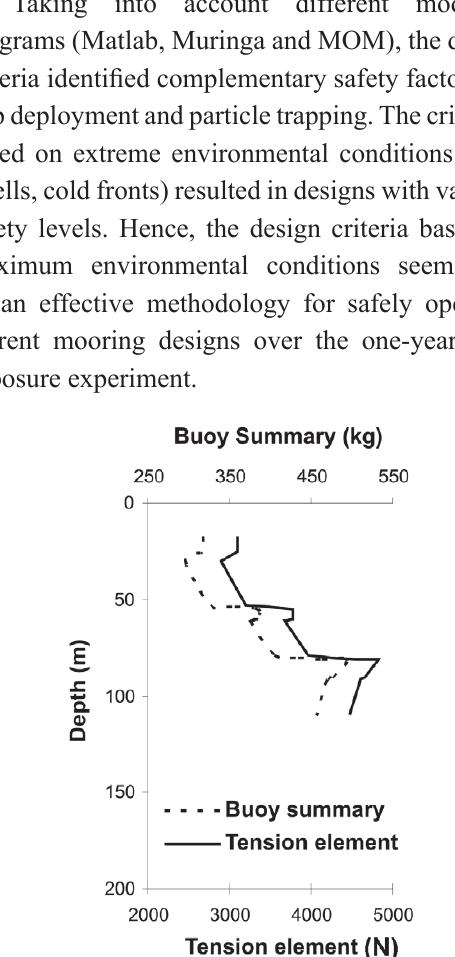
Figure 4 - Muringa modeling of the buoyancy summary and tension element attesting to the correct distribution of the buoys for the maintenance of the mooring array tension.